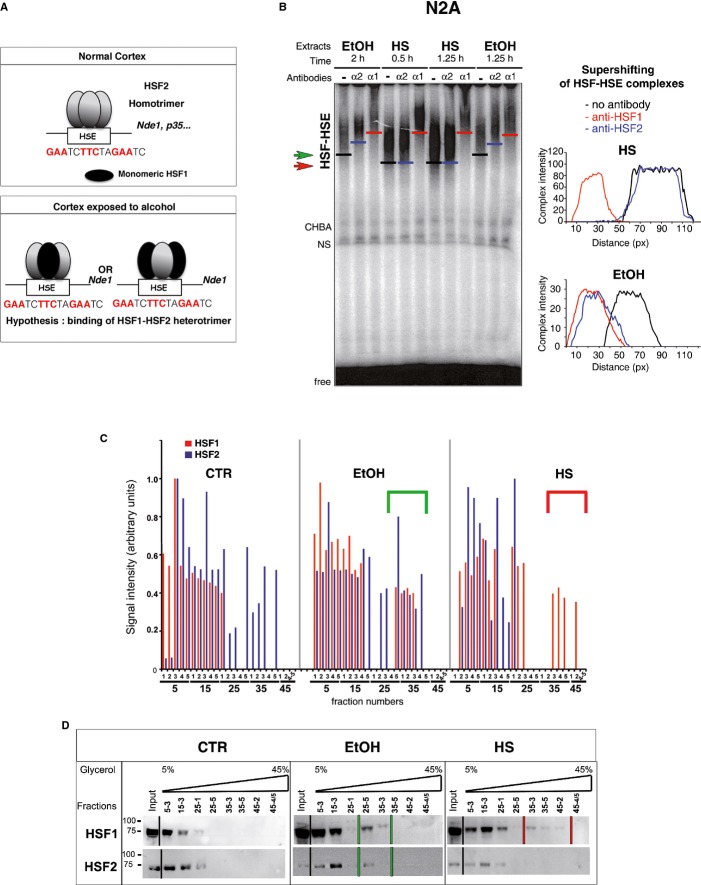
Alcohol induces the formation of HSF1–HSF2 heterocomplexes with specific signaturesA   Hypothesis of HSF binding to the HSE of the Nde1 gene in alcohol-exposed fetal cortices. Control situation: The Nde1 HSE is bound by one HSF2 homotrimer (gray ellipses; HSF2 is known to be active in a trimeric form, Sistonen et al, 1994). HSF1 is inactive and monomeric (black ellipse). CAI: The Nde1 HSE is bound by a single alcohol-specific HSF1–HSF2 heterotrimer. In the heterotrimer, the stoichiometric ratio could be 1 HSF1 monomer to 2 HSF2 monomers, or 2 HSF1 monomers to 1 HSF2 monomer.B   Representative gel-shift assays of extracts from N2A cells exposed to 0.5% EtOH or HS (41°C). The position of each HSF–HSE complex is indicated by one bar. Green arrow, EtOH-induced complex; red arrow, HS-induced complex. The specific supershift induced by the addition of anti-HSF1 (α1) or anti-HSF2 antibodies (α2) was illustrated by red and blue bars, respectively (no antibody: black bars). Right panels, relative positions of the supershifted bands after scan quantification of the HSE–HSF complexes (black curve, no antibody; red curve, with anti-HSF1 antibody; blue curve, with anti-HSF2 antibody). See also Supplementary Fig S5.C   Quantification of the immunoblot signals (arbitrary units) of HSF1 and HSF2 in all fractions after ultracentrifugation on a glycerol gradient. HSF1 (red); HSF2 (blue). Green bracket points to fractions in which HSF1 and HSF2 colocalize upon EtOH exposure. Red bracket represents the trimeric HSF1 forms induced by HS.D   Immunoblot of representative fractions collected as in (C). N2A cells were untreated (CTR), treated with 0.5% EtOH for 5 h, or heat-shocked at 42°C for 2 h. An example of the location of HSF1 and 2 is illustrated here for a representative number of fractions. The presence of HSF1 within fractions of high glycerol concentration is indicated by two bars (red for HS, corresponding to red brackets in (C). The presence of HSF1 and HSF2 in the same high glycerol concentration fractions is indicated by green bars for EtOH), corresponding to green brackets in (C). Note that this WB did not allow to HSF2 to be visualized in denser fractions from control N2A cells, which are presented in Fig 5C and correspond to the fact that HSF2 exhibits basal DNA-binding activity under control conditions in N2A cells.See also Supplementary Figs S8 and S9.Source data is available for this figure.